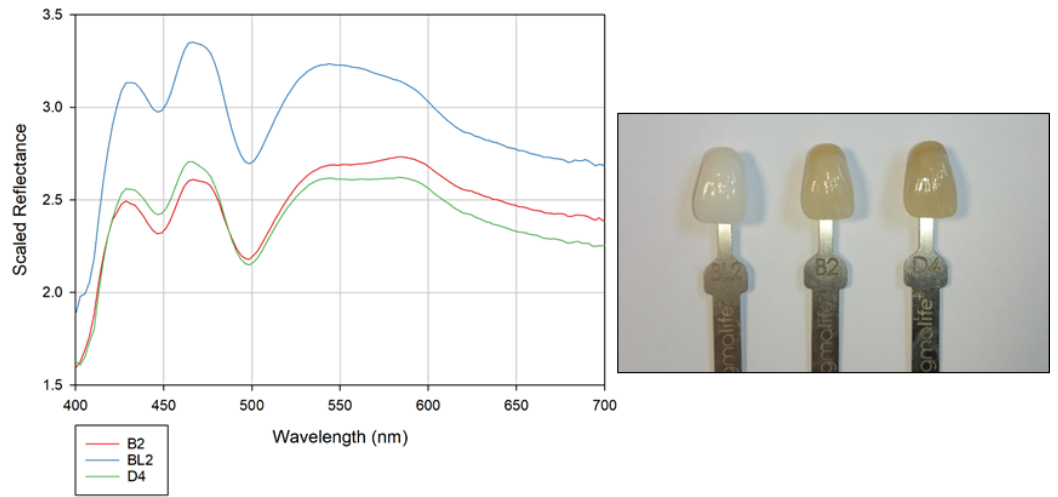
Figure 10. Spectral response across the visible spectrum for three dental shade tabs of varying shades. Scaled reflectance is representative of R Target in Equation (1).